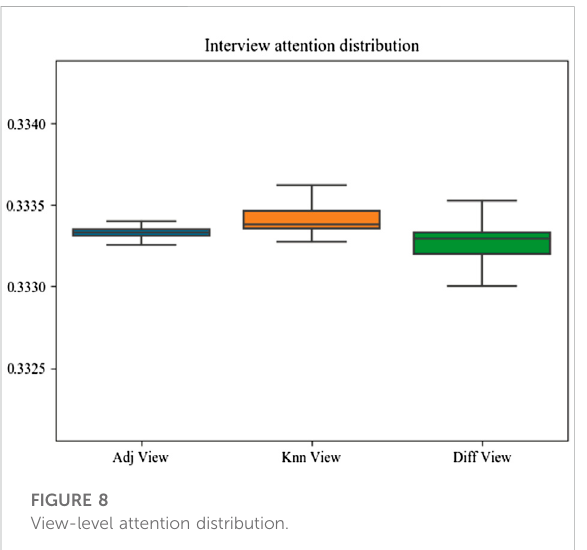
FIGURE 8 View-level attention distribution.